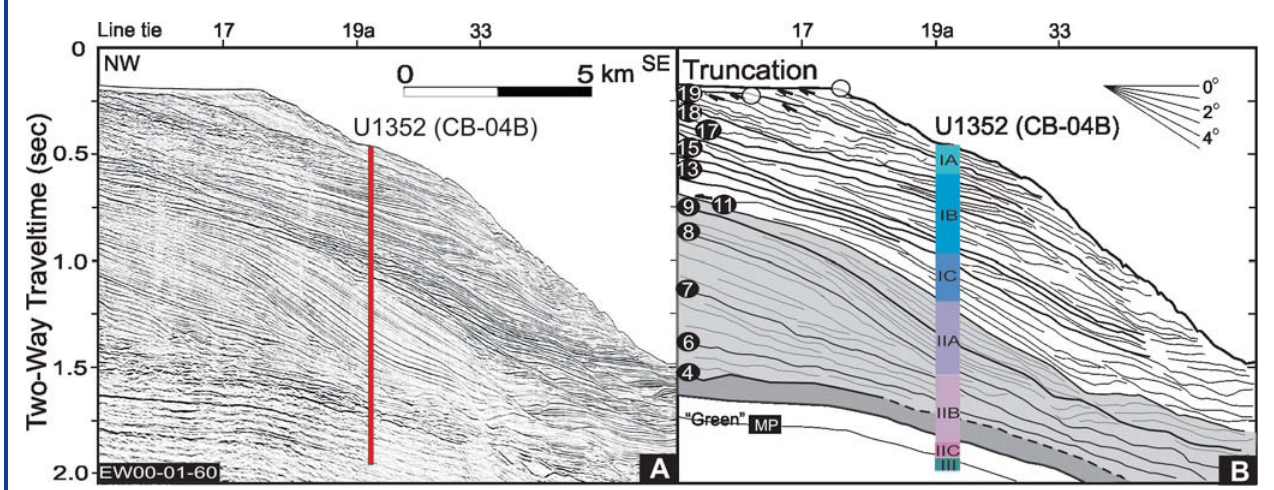
Figure 7. [A] Uninterpreted dip profile EW00-01-60 across the slope in the southern part of the survey grid showing location of Site U1352 (see Fig. 2 for location). [B] Interpretation showing sequence boundaries and selected locations of reflection truncation (arrows). Lithostratigraphic units are also shown. Site U1352 sampled slope facies of sequences, particularly important for age control, as well as the underlying Marshall Paraconformity